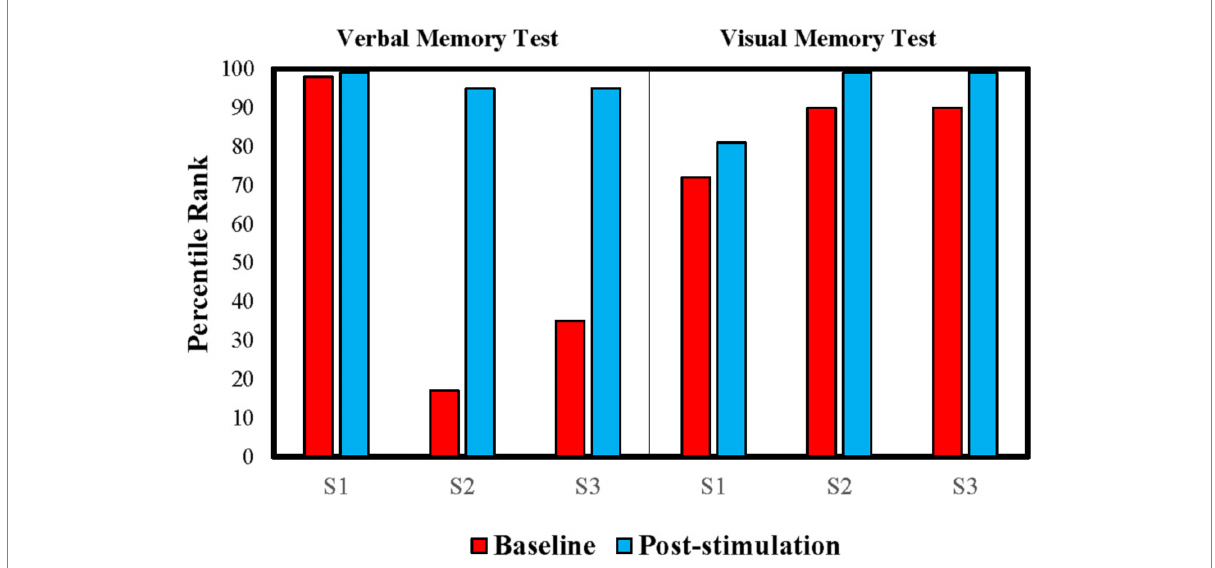
FIGURE 3 Percentile rank of each older adult in visual and verbal memory tests before and after tPBM. Older adults’ visual memory was measured based on the 30-min delayed recall in the Rey–Osterrieth Complex Figure Test (Rey-O), whereas their verbal memory was measured based on the 30-min delayed recall in the